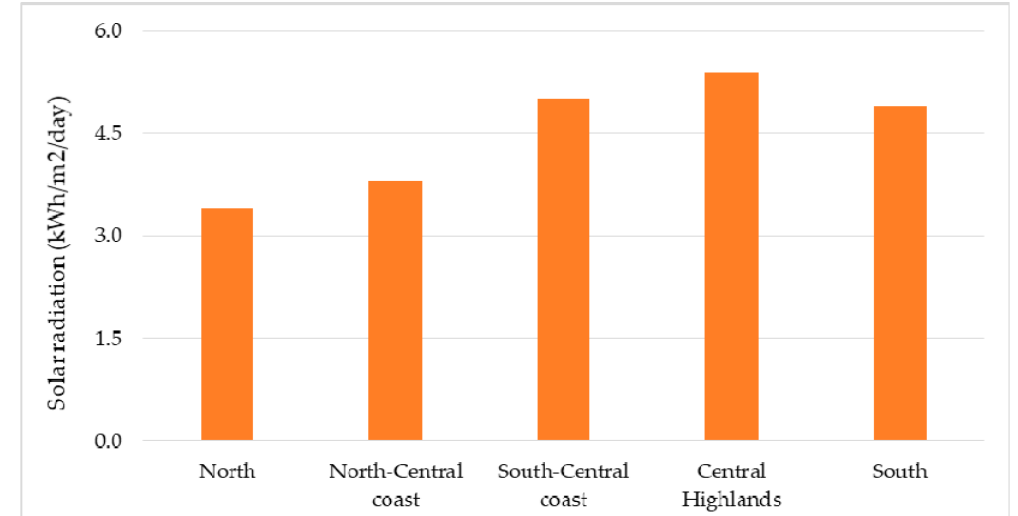
Figure 6. Chart of average of daily and yearly of GHI by WB Group.